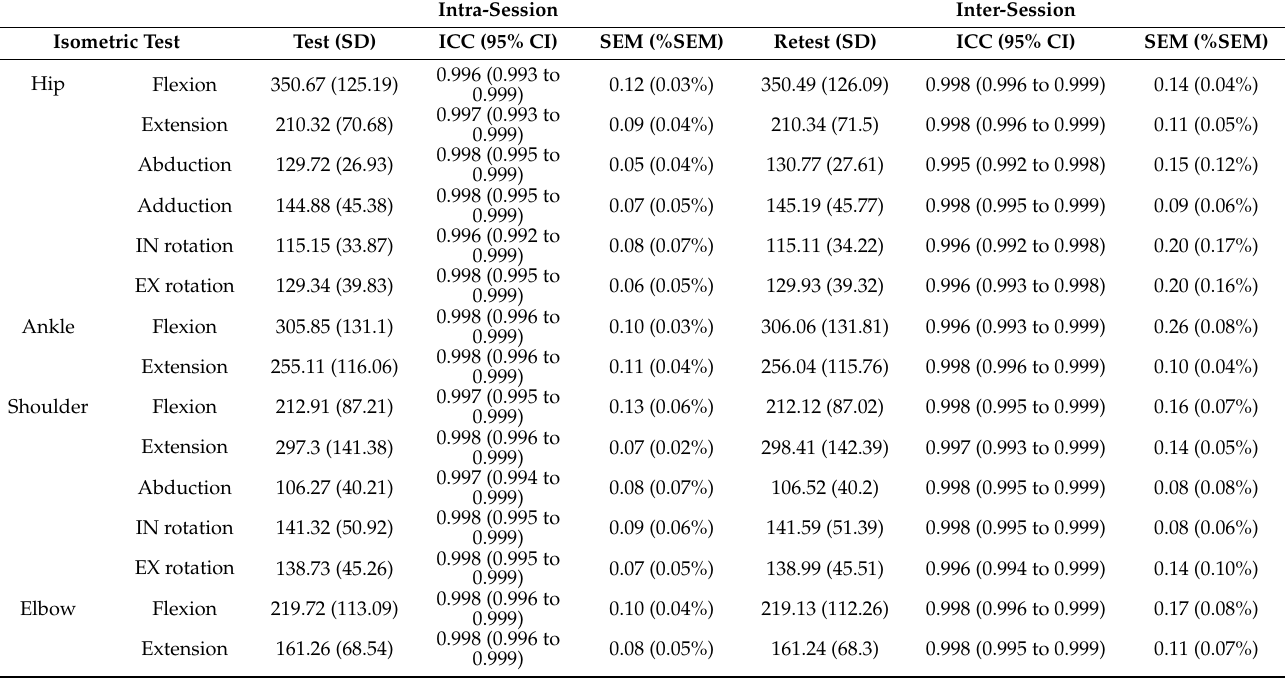
Table 2. Intra-rater reliability for the pull HHD method by movement and session. Intra-Session